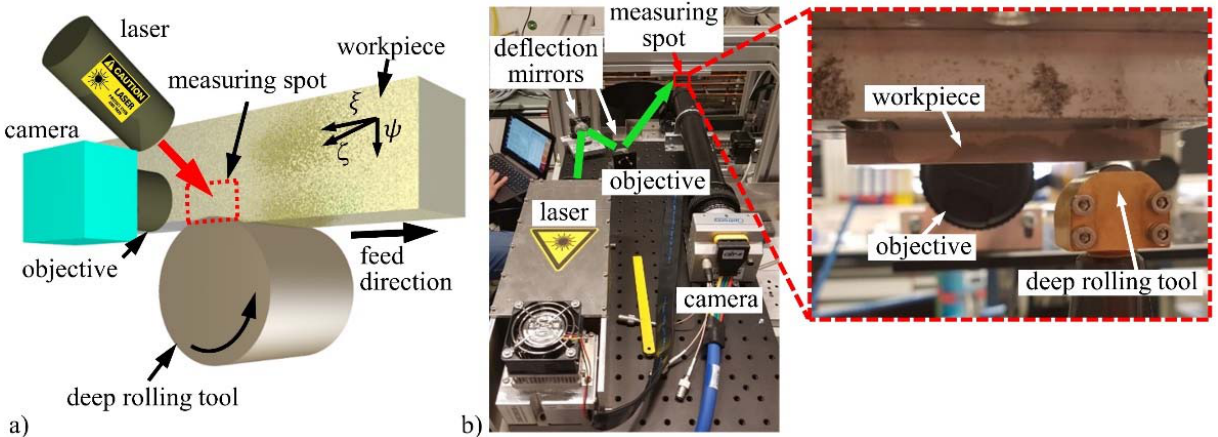
Figure 6. Test setup for deep rolling: Basic measurement setup ( a ) and practical implementation with enlarged view from the opposite ζ -direction to the camera ( b ).